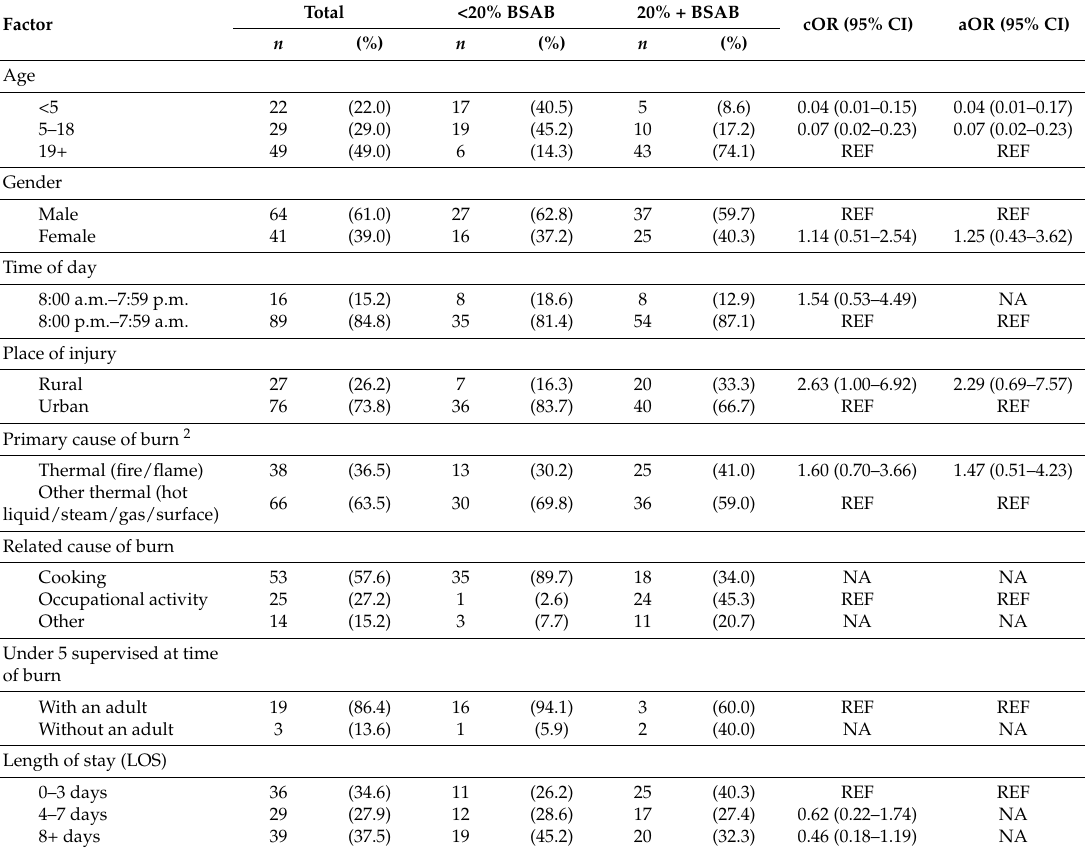
Table 3. Multivariate logistic regression predicting burn severity 1 .